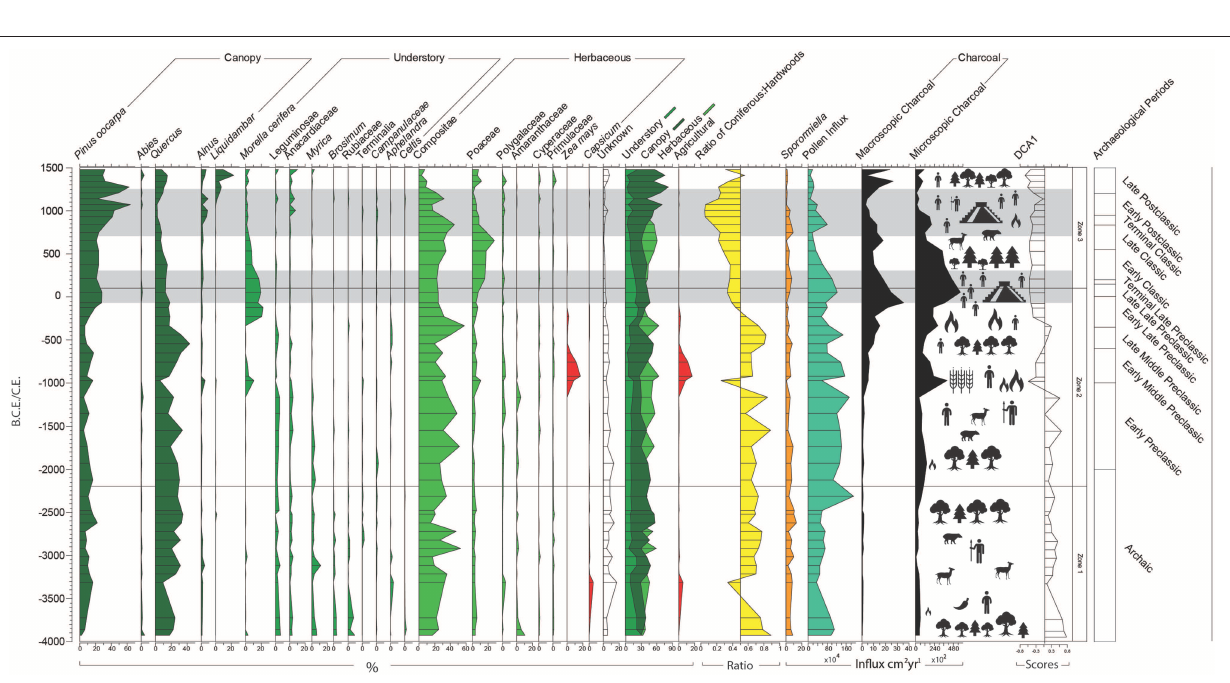
Anacardiaceae (0.3–4.3%), Leguminosae (0–6.3%),